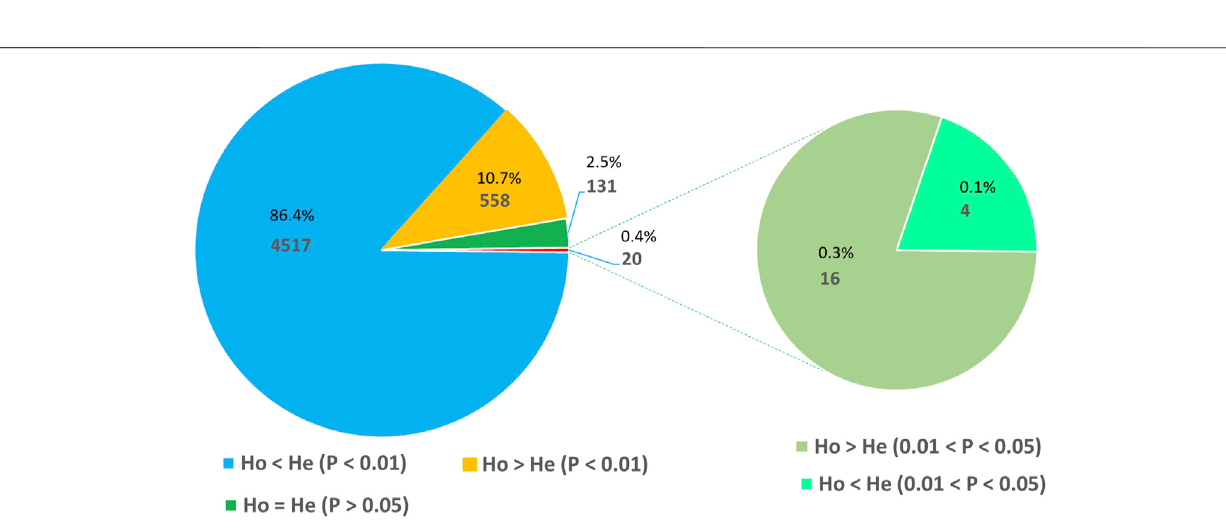
Frontiers in Genetics |